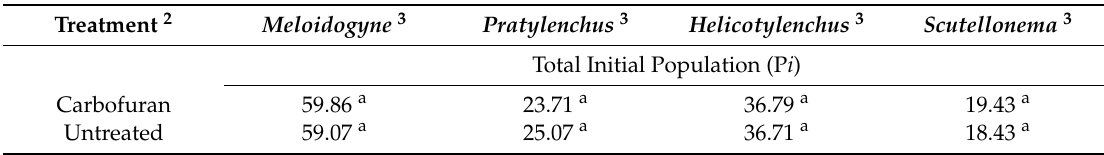
Figure 1. E ff ect of carbofuran on the final population of four major plant-parasitic nematodes encountered in field trials in Nigeria. P f = final density at harvest—12 months after planting; treatments: treated = 3G Carbofuran at 60 g / plot twice; untreated = untreated control. Error bars = Least Significant Di ff erence ( p ≤ 0.05). Table 1. Population of four major plant-parasitic nematodes encountered at planting in field trials in Nigeria 1